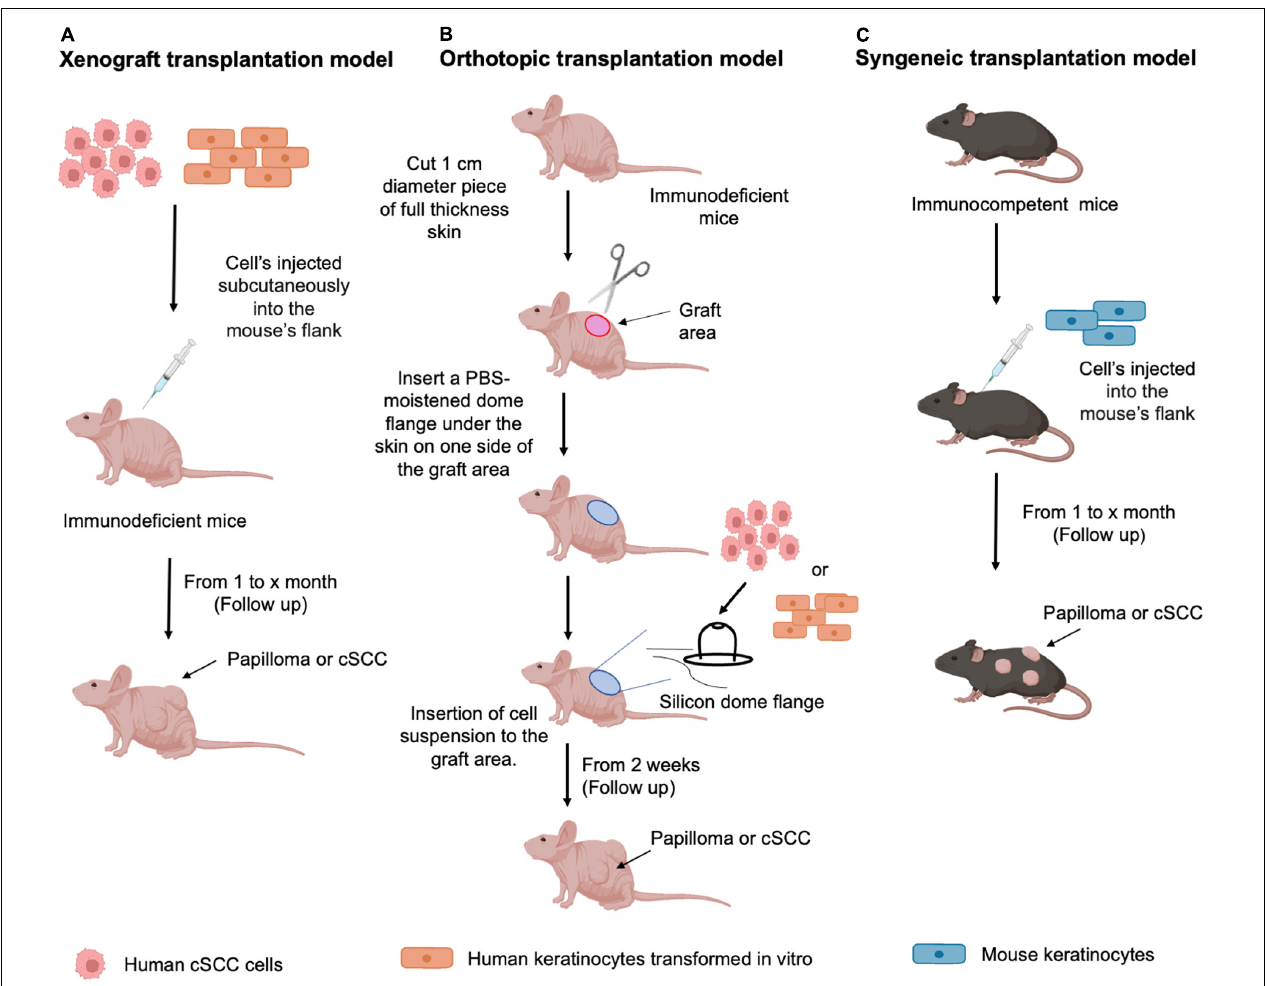
FIGURE 4 | Transplantation mouse models of cSCC. Schematic representation of the protocols used for (A) Xenograft transplantation model: human cSCC cells or human keratinocytes transformed in vitro are subcutaneously inoculated into the appropriate anatomic site (flank) of an immunodeficient murine host. After cell injection, follow up is performed starting from 1 month to evaluate papilloma or cSCC tumor formation; (B) Orthotopic transplantation model: Immunodeficient murine host is prepared for the grafting procedure by cutting 1 cm of full-thickness skin to allow the insertion of the silicone dome flange. Human cSCC cells or human keratinocytes transformed in vitro , mixed with mesenchymal cells, are inserted into the dome. After cell injection, follow up is performed starting from 2 weeks to evaluate papilloma or cSCC tumor formation (C) Syngeneic transplantation model: murine keratinocytes harboring specific characteristics, as described in the text, are injected into the mouse’s flank. After cell injection, follow up is performed starting from 1 month to evaluate papilloma or cSCC tumor